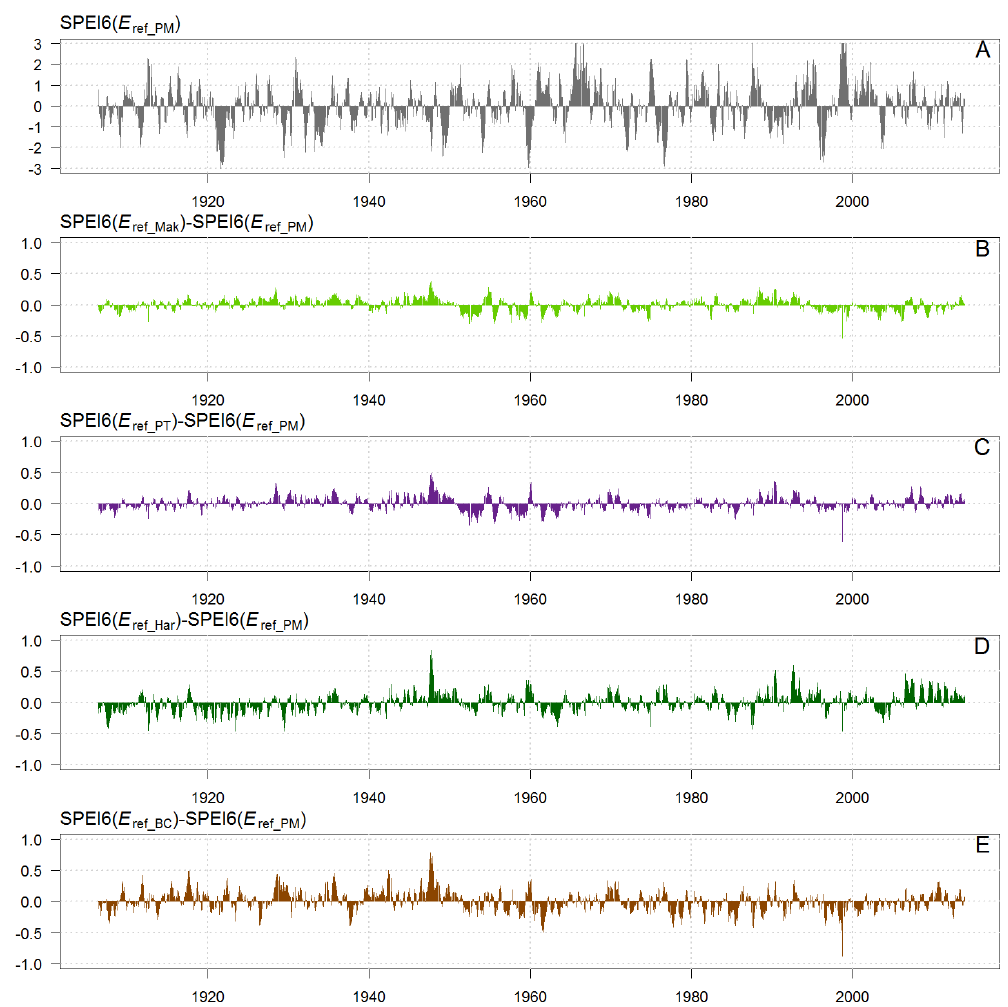
Figure 11. SPEI6 time series with E ref based on PM (a) . The subsequent figures show differences in SPEI with E ref based on Mak (b) , PT (c) , Har (d) and BC (e) , calibrated on the period